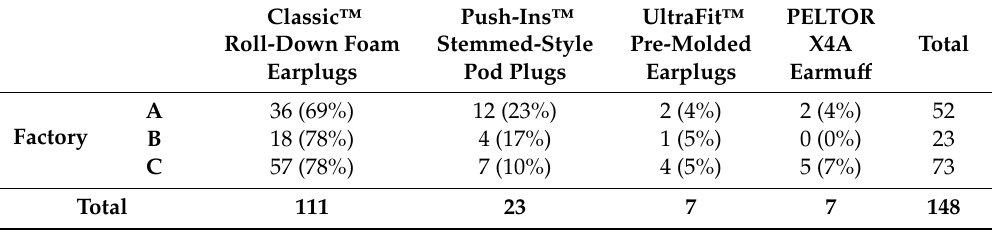
Table 4. Distributions of the 148 PAR tests and percentages of the four types of HPDs at each